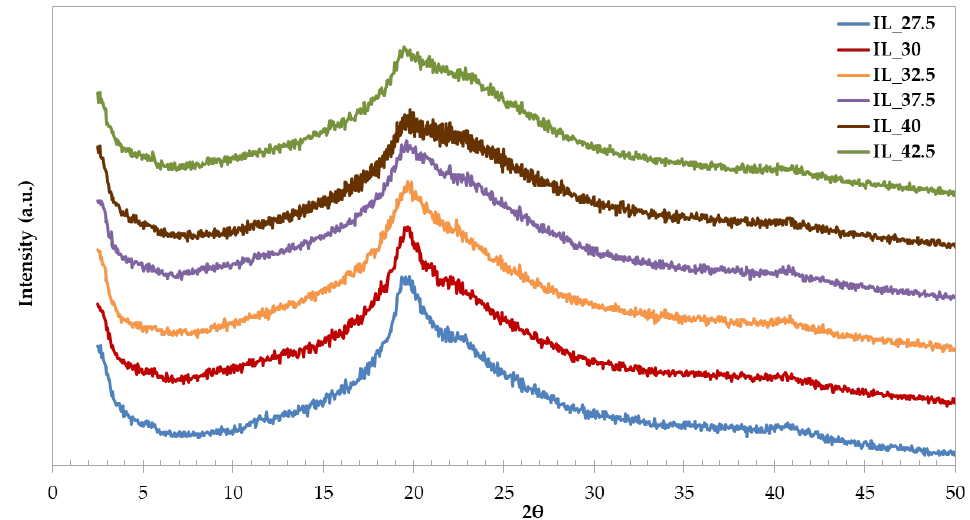
Figure 6. XRD spectra of the starch/PVA blends plasticized by [Emim + ][Ac −